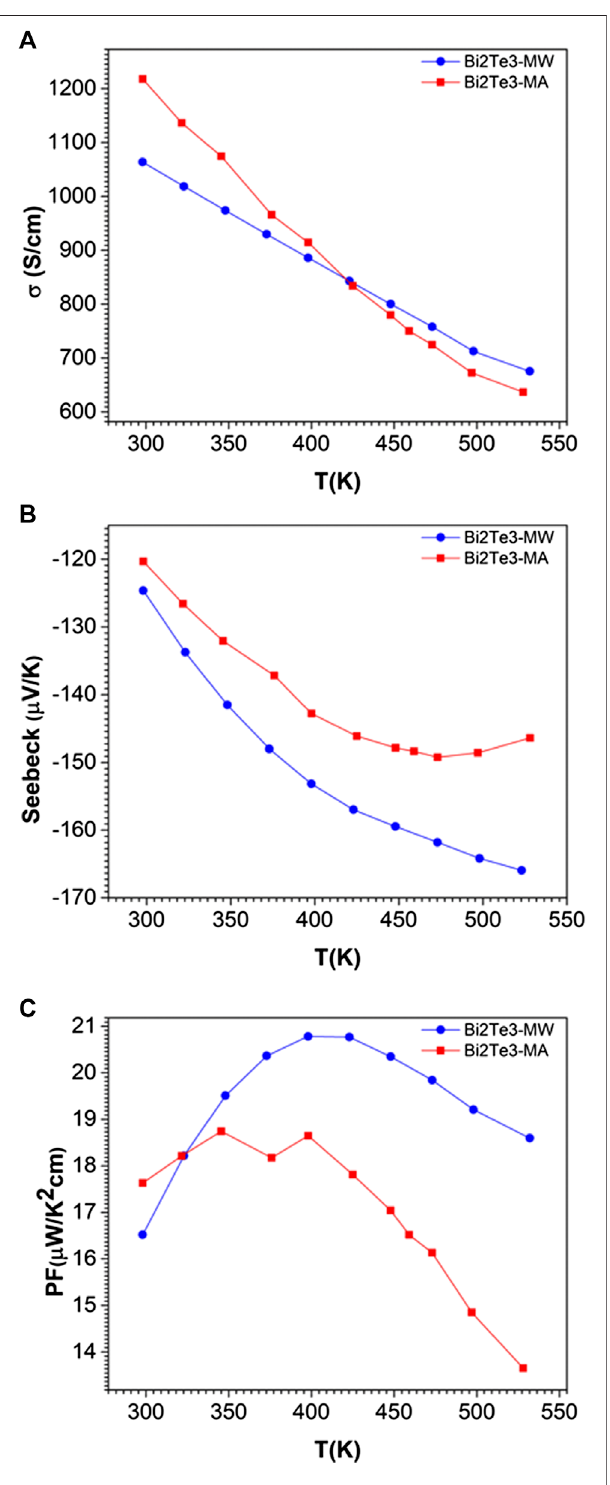
FIGURE4| Temperature-dependenttransportpropertiesofSPsintered MW-Bi 2 Te 3 and MA-Bi 2 Te 3 samples: (A) electrical conductivity ( σ ), (B) Seebeck coef fi cient ( S ), and (C) power factor (PF).